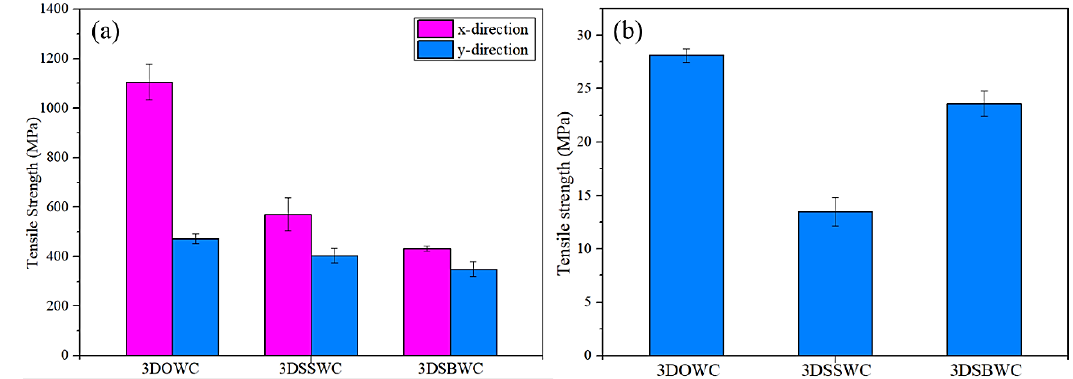
Figure 4. The tensile strength in ( a ) the x- and y-directions and ( b ) the z-direction.